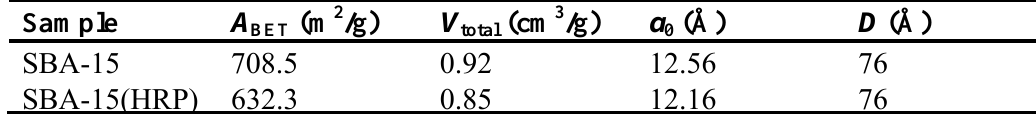
Table 1. Pore characterizations of SBA-15 and